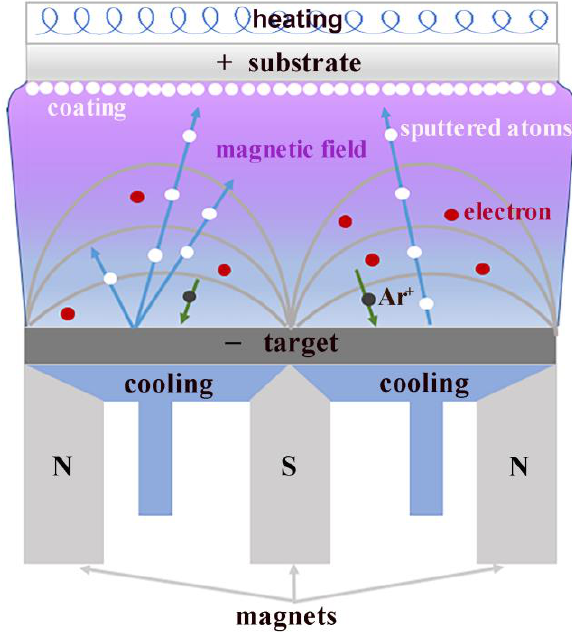
Figure 1. Schematic diagram of magnetron sputtering. Table 2. Deposition parameters for Ta